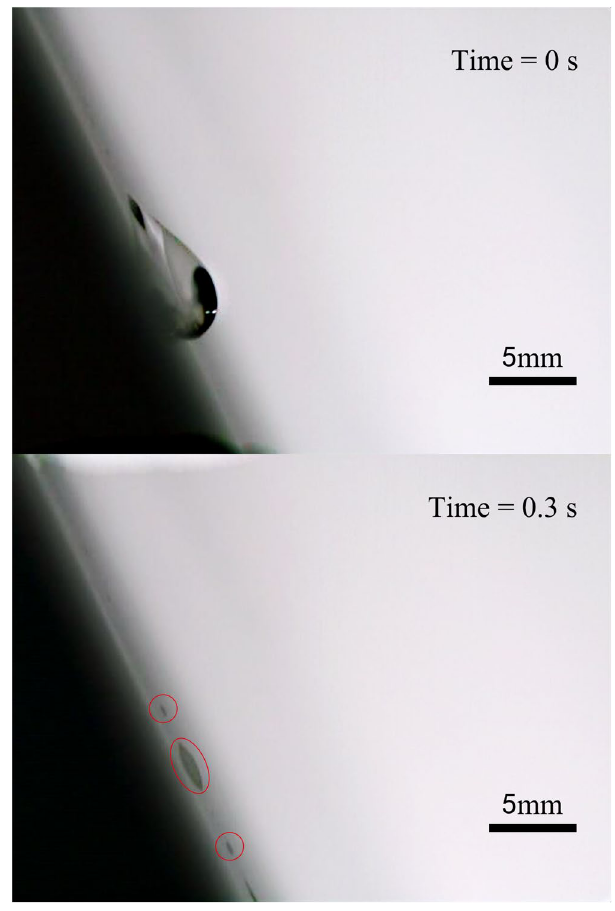
Figure 5. 30 μ l droplet movement induced by the 1 MHz Lamb waves at an inclination angle of 60°. The first and third pearls were dropped near the position of droplet’s advancing end of initial state; the second pearl was dropped just at the position of droplet’s advancing end of initial state.